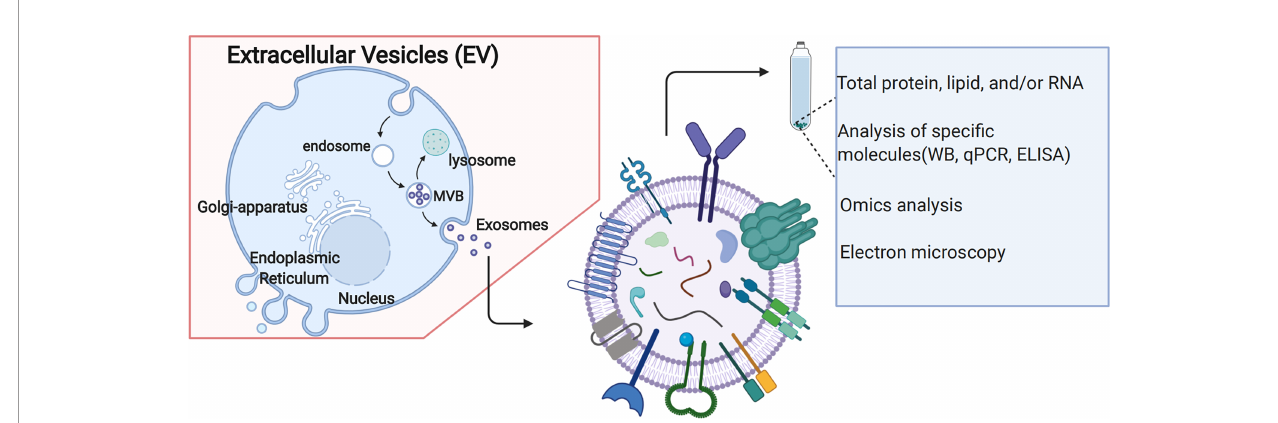
FIGURE 4 | Extracellular vehicles (EVs) Biogenesis.